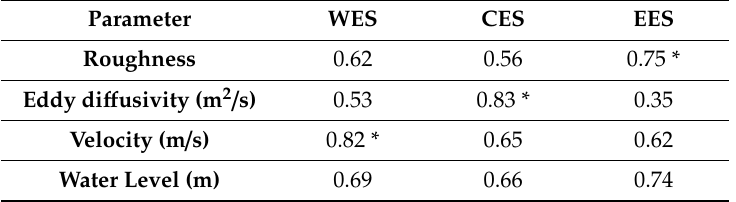
Table 1. Results of Principal Component